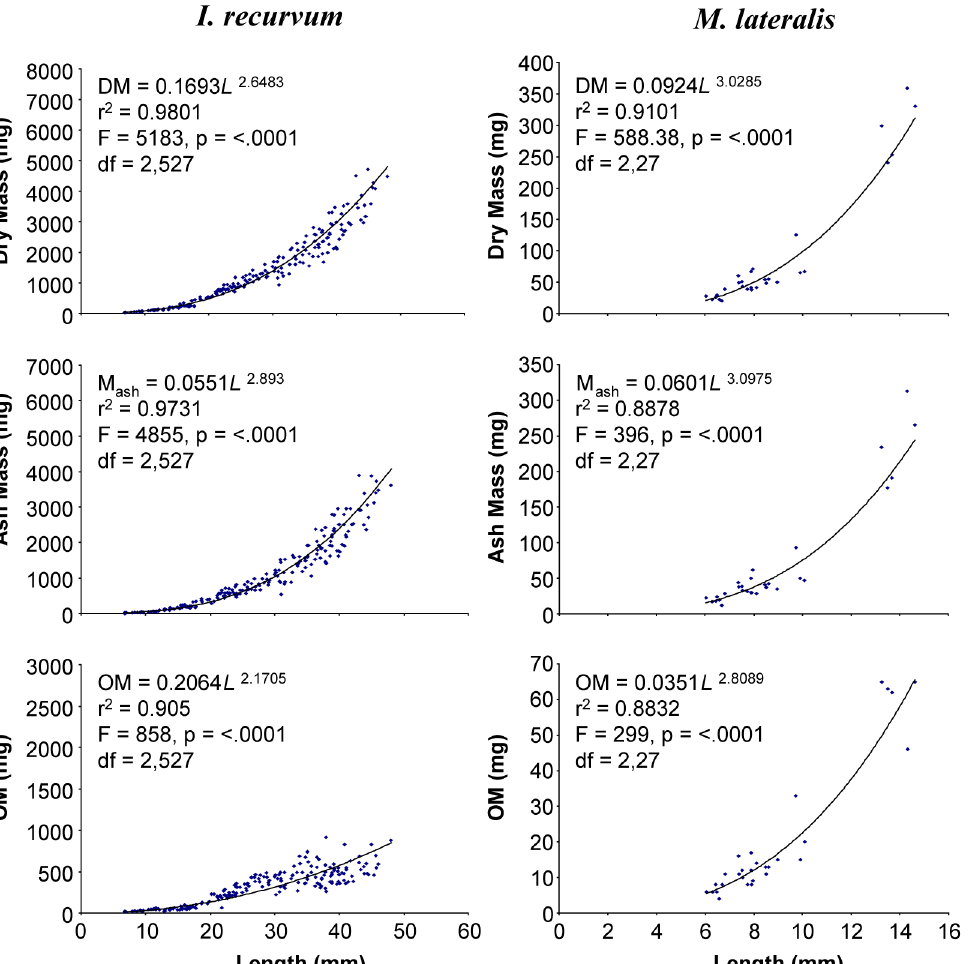
Fig 3. Dry, ash, and organic matter masses of Ischadium recurvum and Mulinia lateralis relative to shell length. Dry mass (DM; mg), ash mass (M ash ; mg), and organic matter (OM; mg) of Ischadium recurvum and Mulinia lateralis (including shell) as a function of length (mm). All regressions were significant at the 5% level (p < 0.0001).